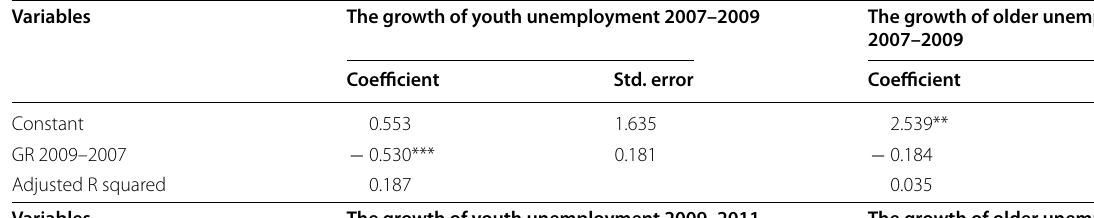
Table 4 Unemployment rate as a function of the business cycle